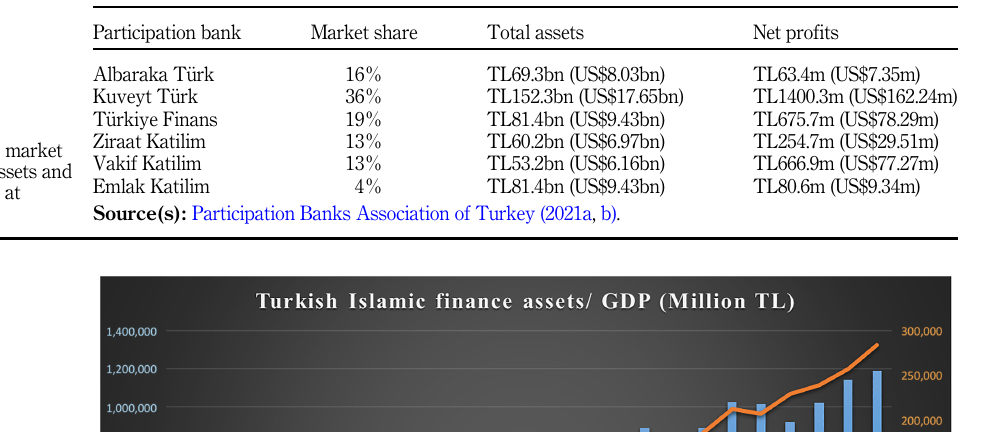
Figure 1. The growth of Islamic finance assets alongside gross domestic product (GDP) over the